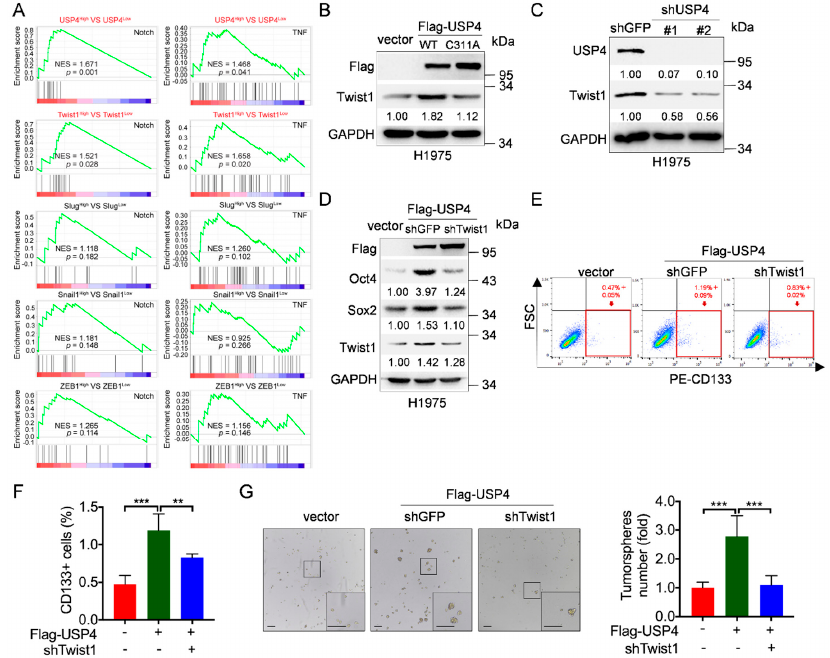
Figure 2. USP4 promotes lung cancer stemness via upregulation of Twist1 protein expression. ( A ) Gene Set Enrichment Analyses (GSEA) analyzed the e ff ects of USP4 or transcriptional factors associated with EMT (Twist1, Slug, Snail and ZEB1) on Notch signaling and TNF signaling. GSE19804 dataset was used to these analyses. NES: normalized enrichment score. ( B ) H1975 cells stably expressing Flag-USP4